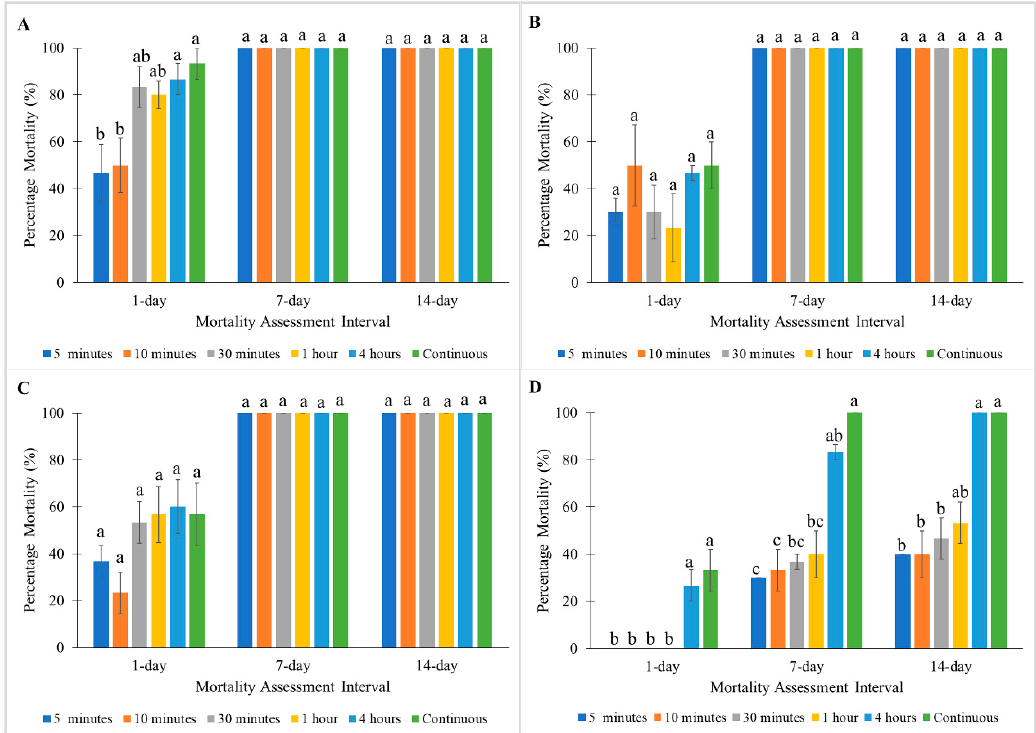
Figure 6. Influence of exposure time on Phantom on percentage mortalities of a susceptible C. lectularius strain and three C. hemipterus strains at 1, 7, and 14 days post-treatment. ( A ) Monheim, ( B ) Madam Mo, ( C ) Tanjong Tokong, ( D ) Green Lane strains. Bars with different letters are significantly different (Kruskal–Wallis test, p < 0.05).